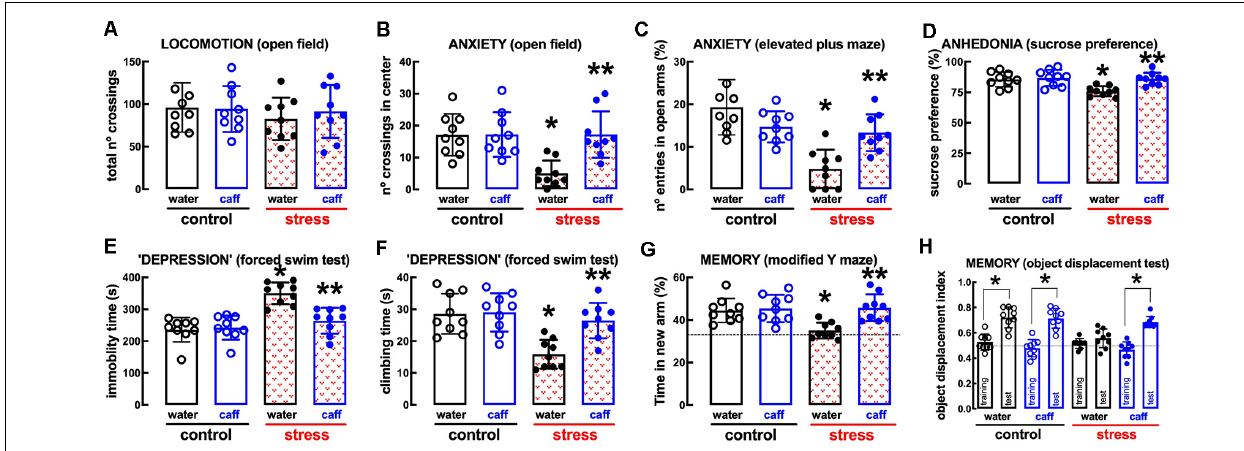
FIGURE 6 | Male adult Wistar rats (8–10 weeks old) subject to a protocol of restraint stress (4 h/day) during 14 days display the expected features of depressed rats, which were prevented by the adenosine receptor antagonist caffeine (caff). Whereas caffeine consumption (0.3 g/L, po, beginning 3 days before the stress protocol and until the sacrifice of the animals; blue) was devoid of effects in non-stressed control rats (open bars), caffeine prevented all behavioral modifications of stressed rats (red checkered bars): without modification of locomotor activity as evaluated in the open field (A) , caffeine prevented anxiety-like behavior as evaluated in the open field (B) and in the elevated plus-maze (C) tests, anhedonia as evaluated in the sucrose preference test (D) , helpless-like behavior as evaluated by the forced-swimming test (E,F) and impaired memory performance as evaluated by a modified Y maze test (G) and an object-displacement test (H) . Data are shown as mean ± SEM; n = 8–9 rats per group. * P < 0.05 vs. control-water, ** P < 0.05 vs. stress-water using a Tukey’s multiple comparisons post hoc test after a two-way ANOVA.